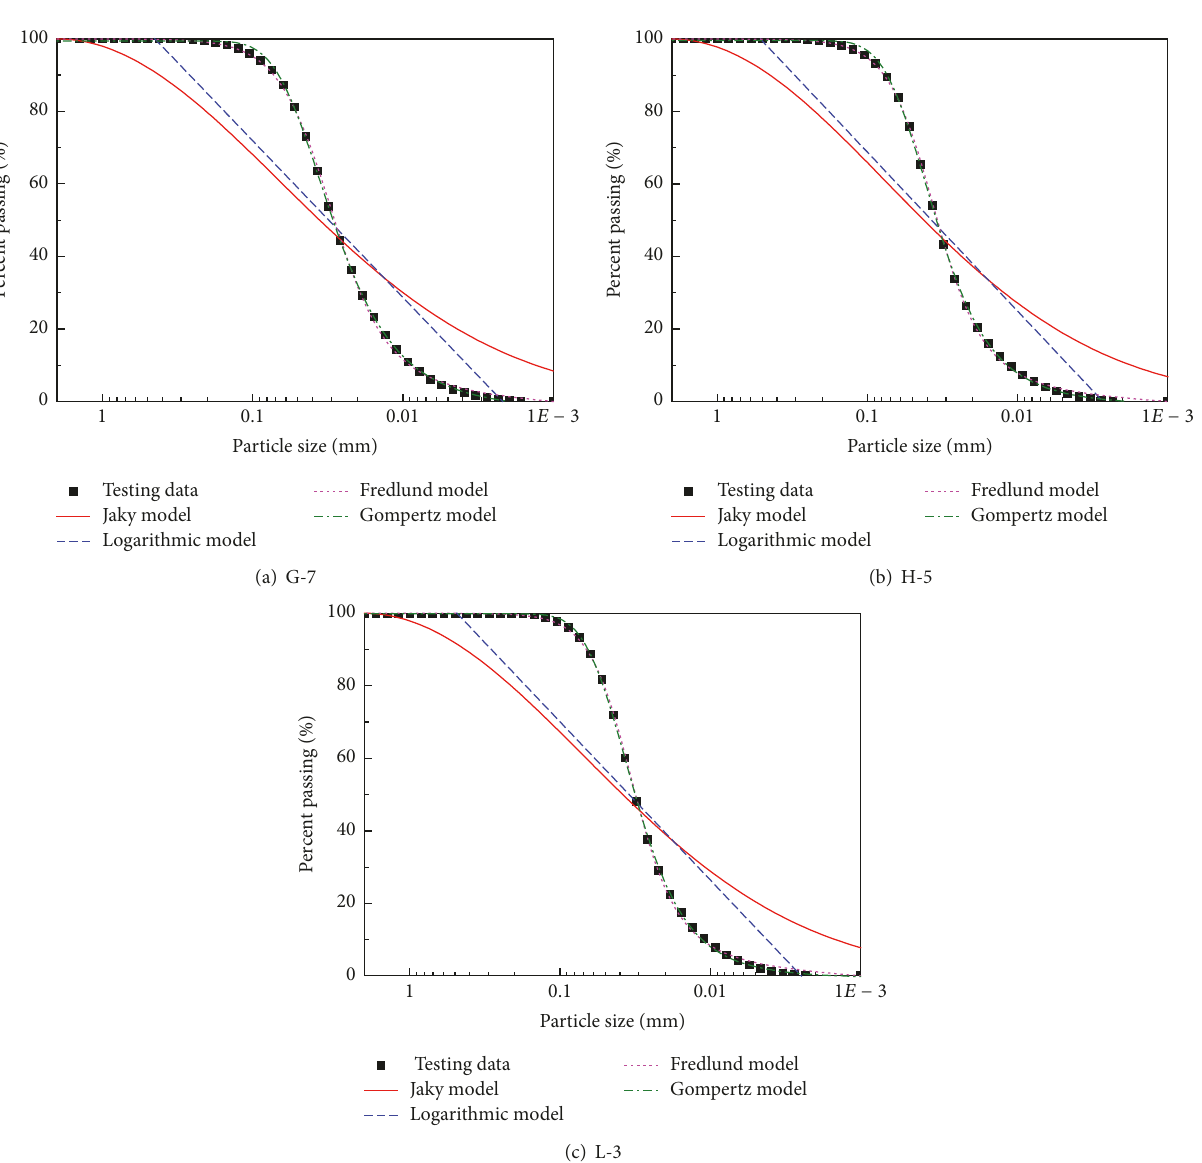
Figure 4: Performance of models fitted to LD particle size